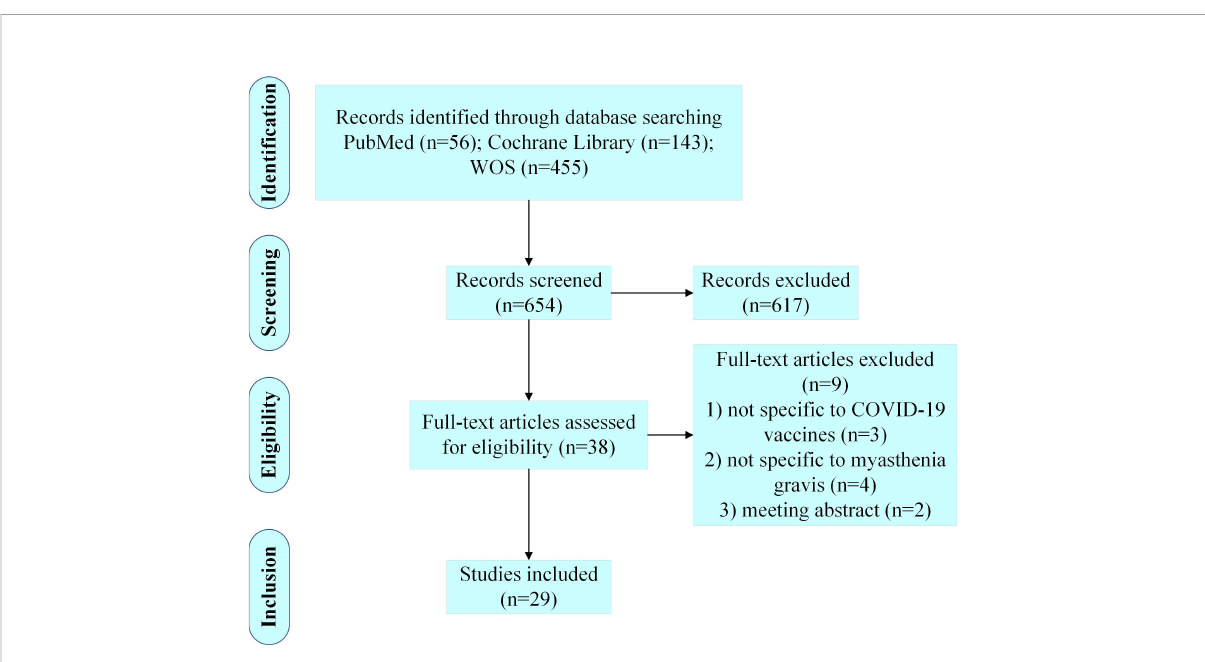
FIGURE 1 Diagram for scoping review literature identi fi